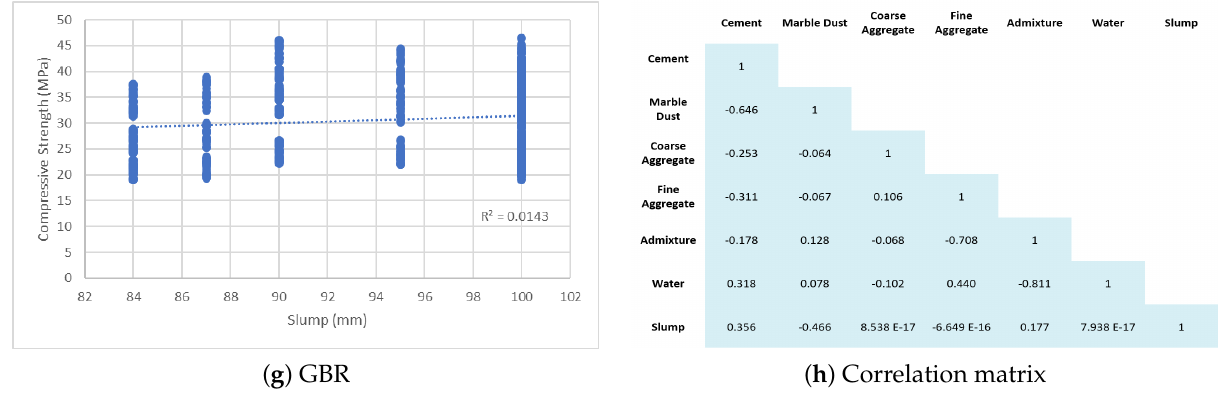
Figure 1. ( a – g ) Correlation between input variables and compressive strength; ( h ) Correlation between various input